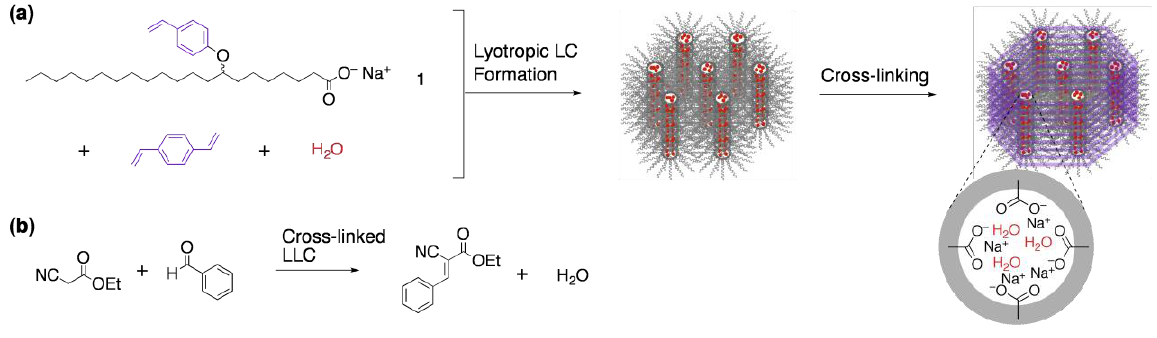
Figure 2. Heterogeneous catalyst based on the cross-linking of a lyotropic LC: ( a ) preparation; and ( b ) application, as a heterogeneous catalyst of the Knoevenagel